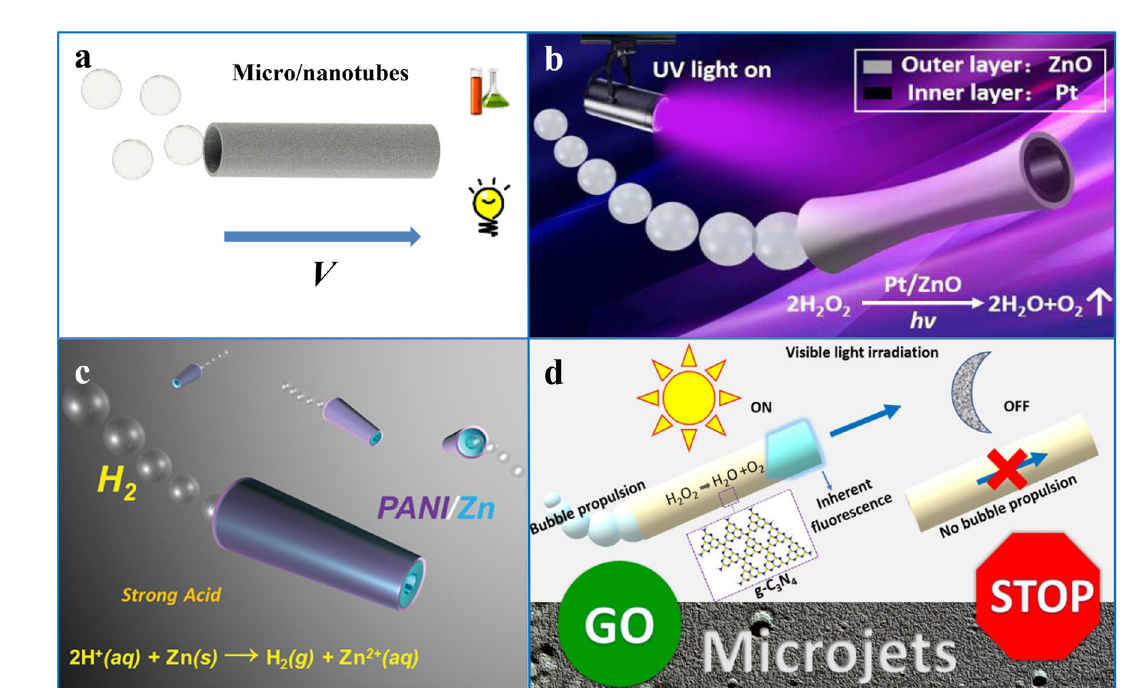
Fig. 7 a Schematic diagram of bubble driven tubular micro/nanomotors. b ZnO/Pt tubular micromotor driven in a chemical environment. Reproduced with permission from Ref. [23]. Copyright (2017) Royal Society of Chemical. c PANI/Zn tubular micrometer motor driven in a strong acid environment. Reprinted with permission from Ref. [41]. Copyright (2012) American Chemical Society. d Driving of a g-C 3 N 4 tubu- lar micrometer motor in a light field. Reprinted with permission from Ref. [79]. Copyright (2018) American Chemical